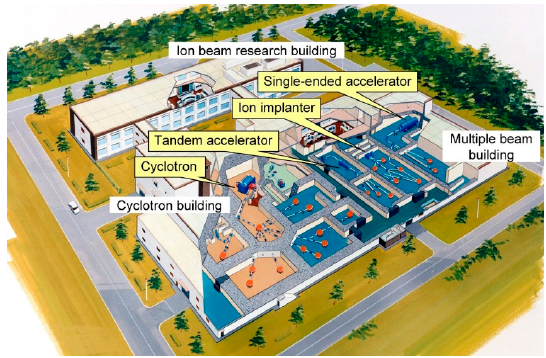
Figure 2. An illustration of TIARA buildings with the accelerators and the beam lines.